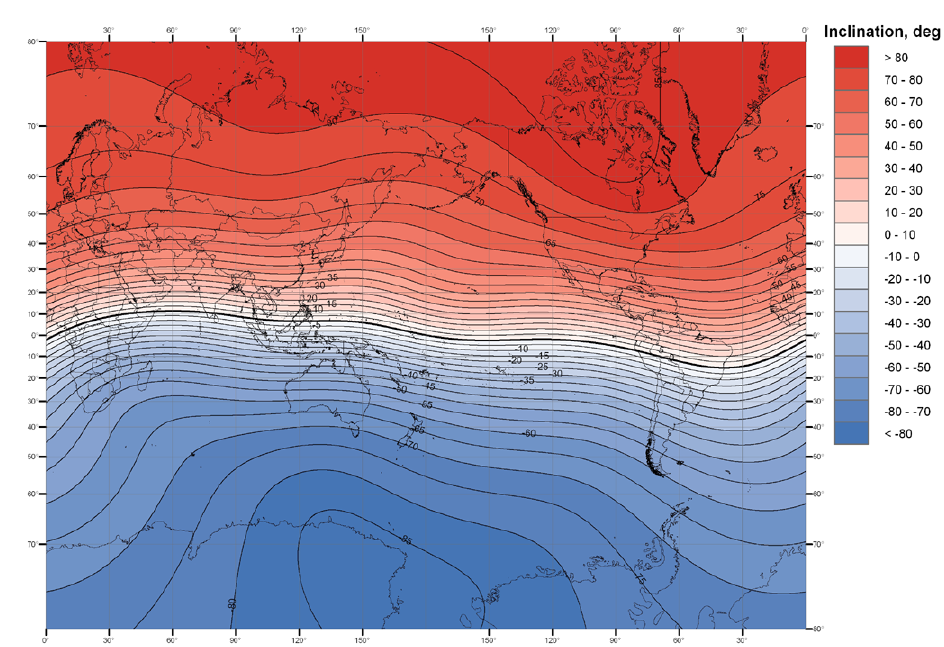
Figure 9. World map of isoclines for 1830 calculated according to gufm1 model. Magnetic equator is marked with a bold line.